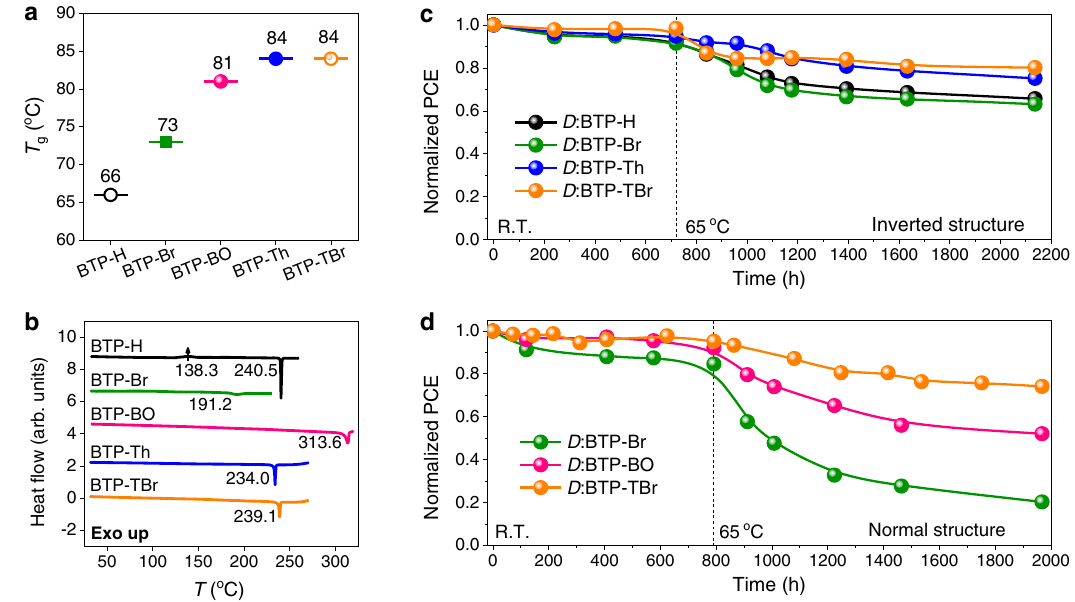
Fig. 3 | Thermal properties of acceptors and long-term stability of solar cells. a T g of acceptors as fi lm state extracted from the deviation metric of absorption spectra under different temperatures. b DSC thermograms for neat acceptors,